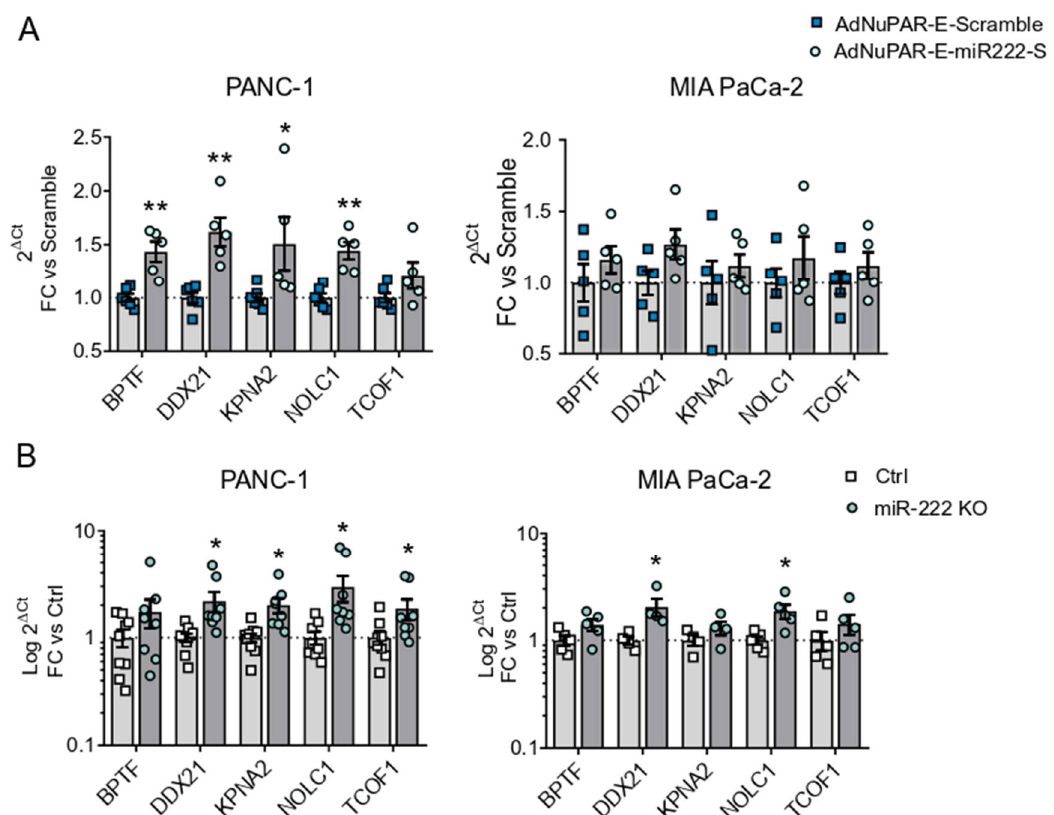
Figure 5. Effects of miR-222 depletion on the expression of selected miR-222 target genes. ( A ) qRT-PCR expression analysis of bioinformatically identified miR-222 target genes in PANC-1 or MIA PaCa-2 cells 24 h PI with 10 IFU/cell of AdNuPAR- E-Scramble or AdNuPAR-E-miR222-S. ( B ) qRT-PCR expression analysis of bioinformatically identified miR-222 target genes in Ctrl and CRISPR miR-222 PANC-1 KO and MIA PaCa-2 KO cells. Data are shown as mean ± SEM for at least five independent biological replicates. Significance was assessed using a two-tailed Mann-Whitney test. * p < 0.05, ** p < 0.01. Table 2. ID50 values of AdNuPAR-E-222-S and AdNuPAR-E-Scramble in different PDAC cell lines. Cell